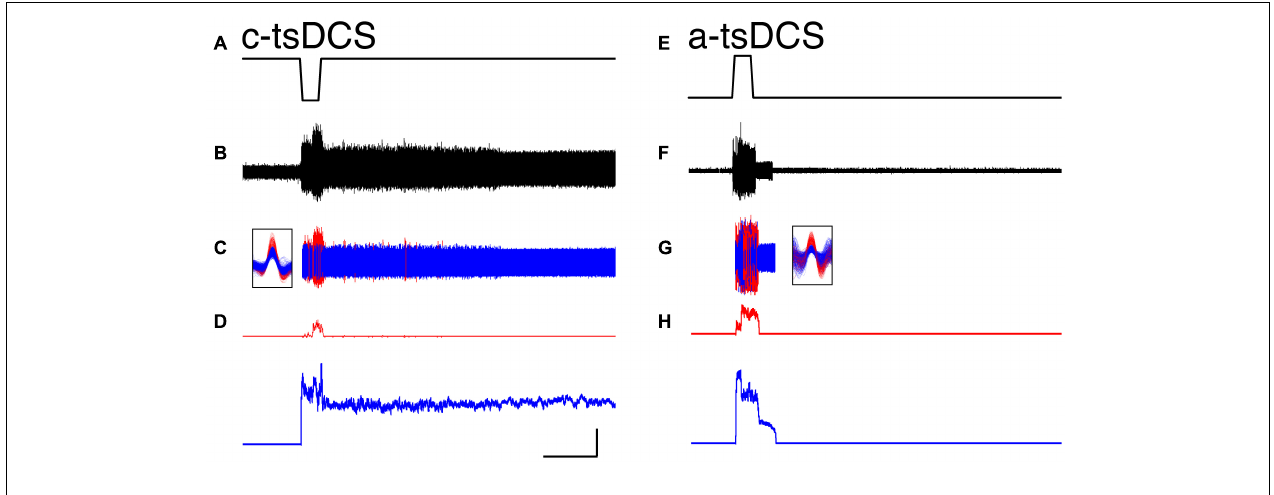
FIGURE 2 | Representative single motor unit responses during trans-spinal direct current stimulation (tsDCS) [ (A,E) ; ± 3 mA] during cathodal-tsDCS (c-tsDCS) (A–D) and anodal-tsDCS (a-tsDCS) (E–H) . Raw EMG activity (B) , single motor unit activity [ (C) ; red, blue for each unit], and response histograms (D) are shown. The unit waveforms were sorted from the raw EMG recording. Both c-tsDCS and a-tsDCS induced single motor unit responses during the stimulation period (direct response). Whereas responses persisted after stimulation stops for both polarities, c-tsDCS (B–D) evoked long-duration persistent responses. During a-tsDCS (E–H) , there was a brief persistent response. Note, the responses were truncated at 380s; the activity of the blue unit in A persisted for a total of approximately 532s. Calibration: 50s, 50